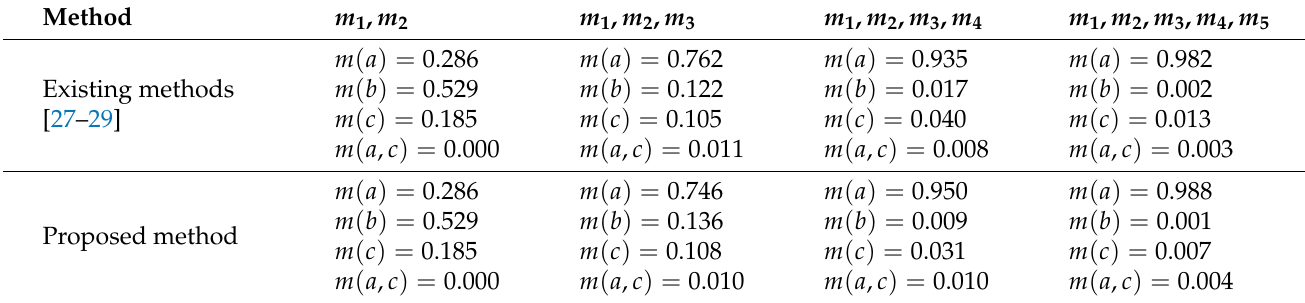
Table 10. The result of combining conflicting evidence with different methods in the Example